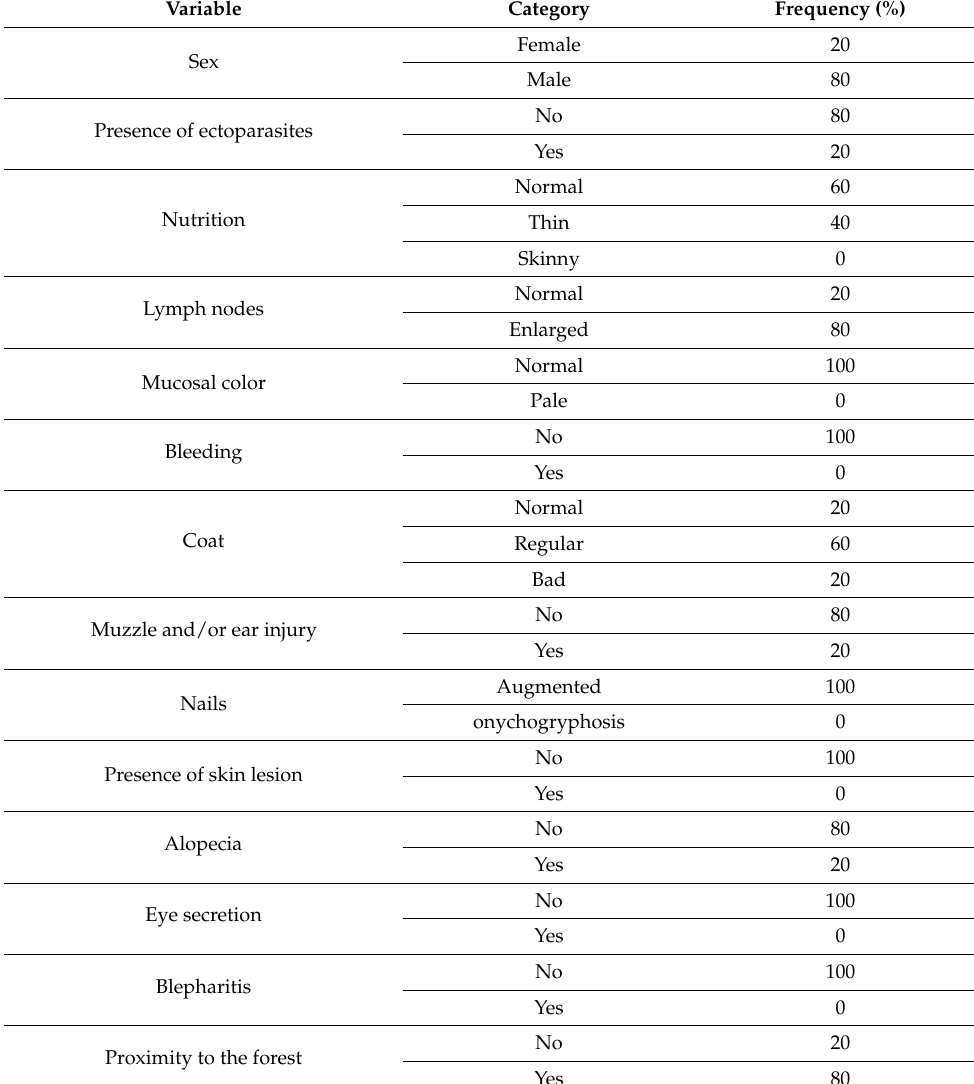
Table 5. Frequency of the variables for the false negatives